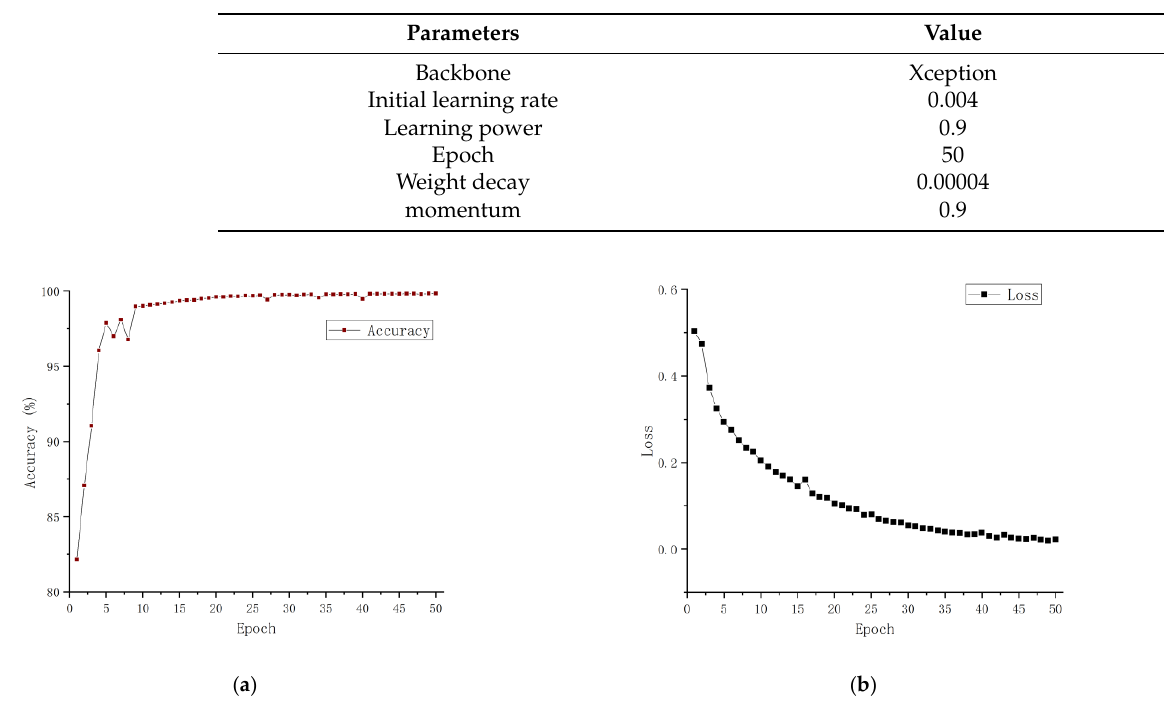
Figure 7. Accuracy and loss curves obtained on the training dataset. ( a ) The accuracy curve, and ( b ) the loss curve.